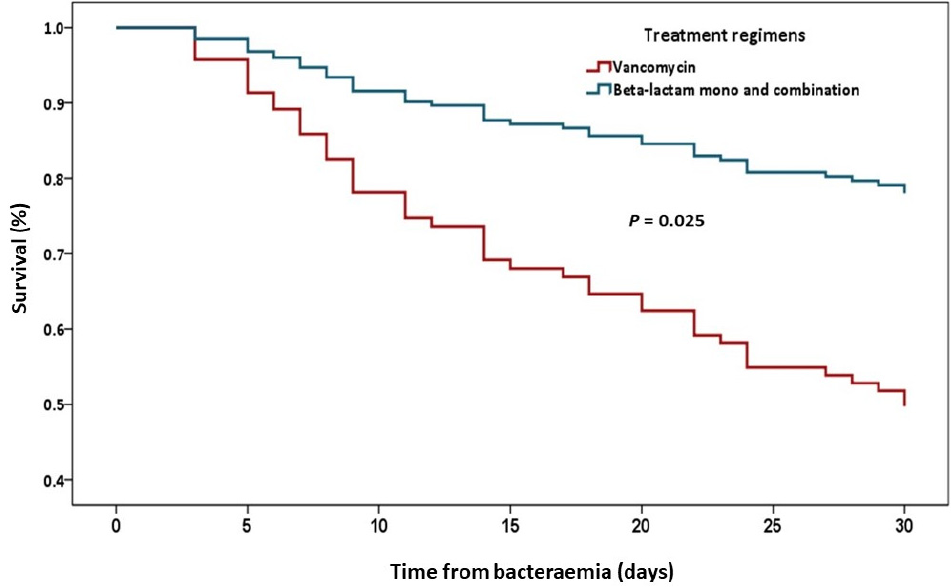
Figure 1. Kaplan ‐ Meier survival curve for 30 ‐ day mortality between antibiotic